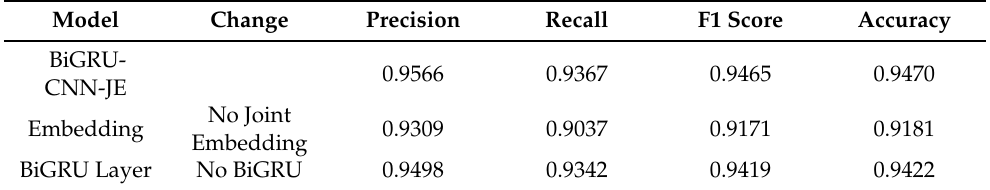
Table 5. Ablation experiment targeting components of the BiGRU-CNN-JE